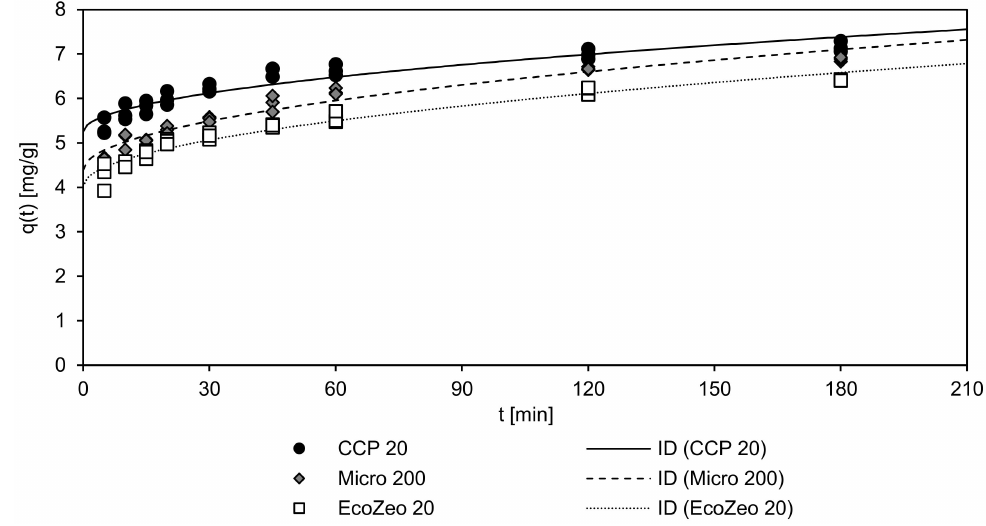
Figure 4. Loading of CCP 20, Micro 200, and EcoZeo 20 as a function of the contact time (c 0 = 1000